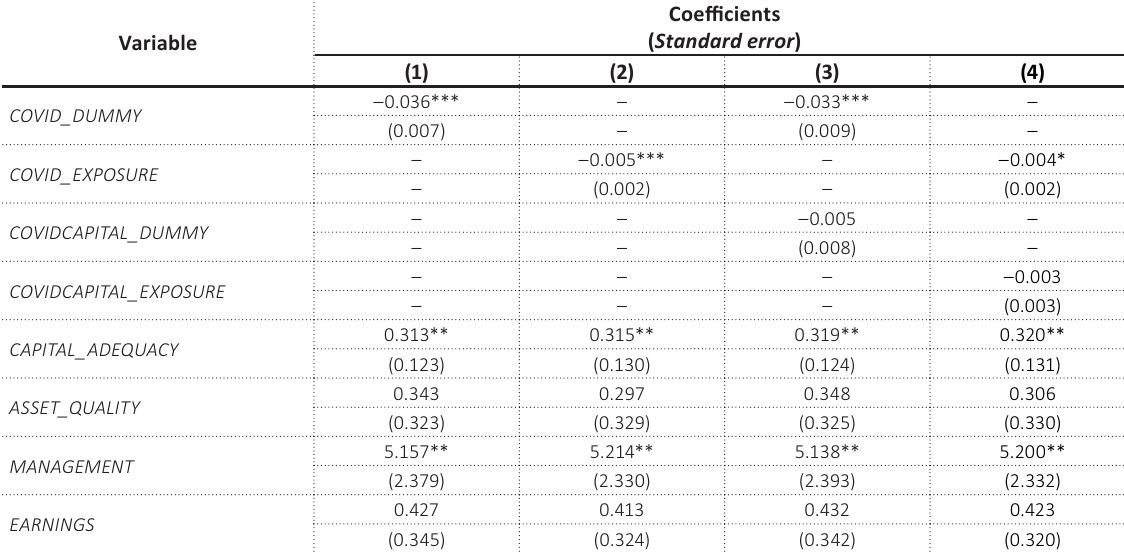
Table 3. Regression